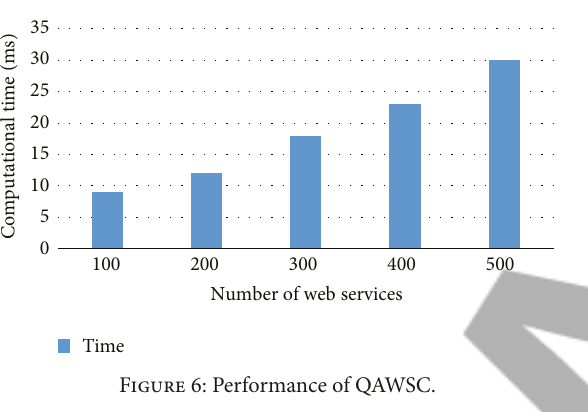
Figure 7: Performance of QAWSC for different number of